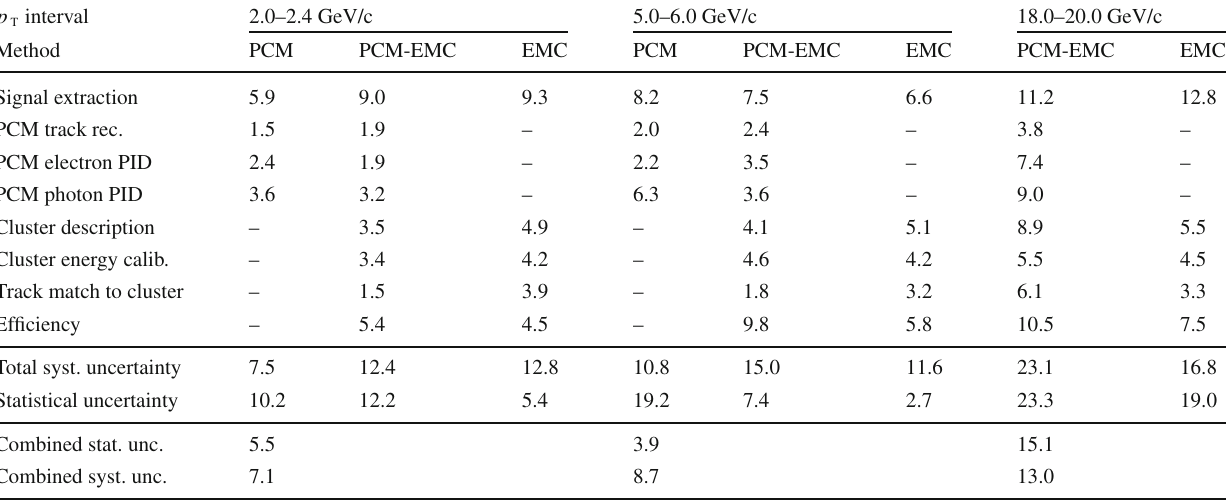
Table 4 Summary of relative systematic uncertainties in percent for selected p T bins for the determination of the η/π 0 ratio. The statistical uncertainties are given in addition to the total systematic uncertainties p T